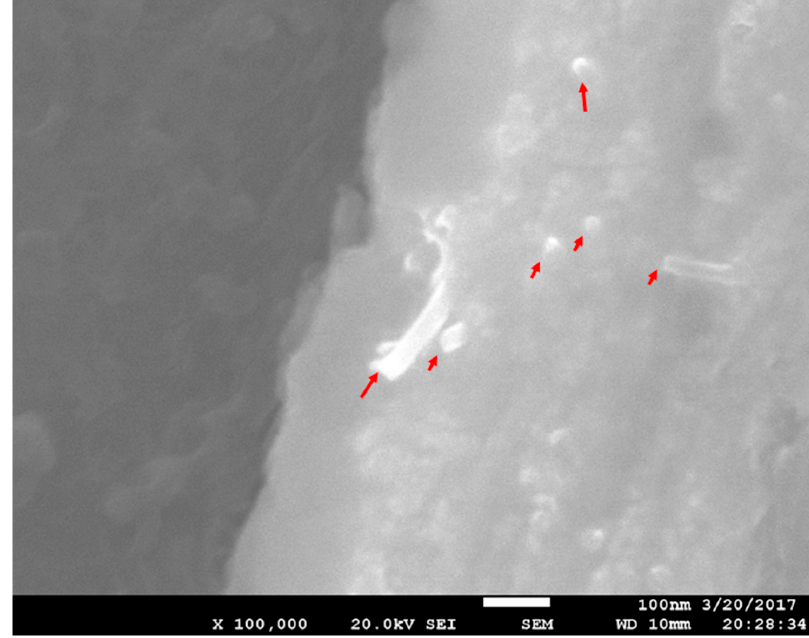
Figure 5. SEM (scanning electron microscope) images of the CNT distribution in the as-extruded composites with 1 wt. % CNTs.